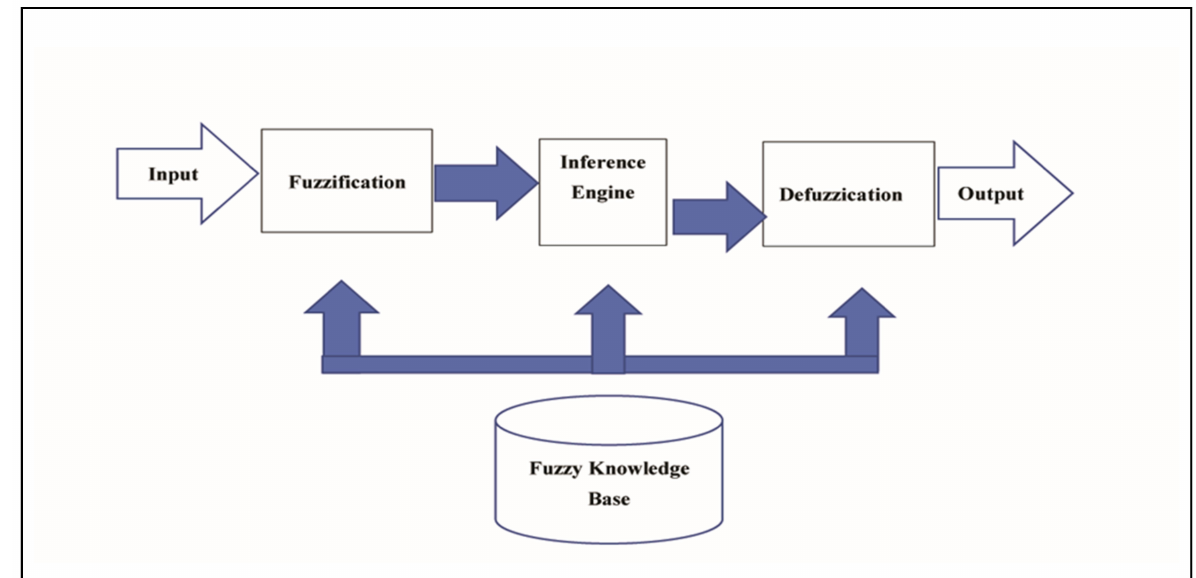
Figure 3. Fuzzy Inference